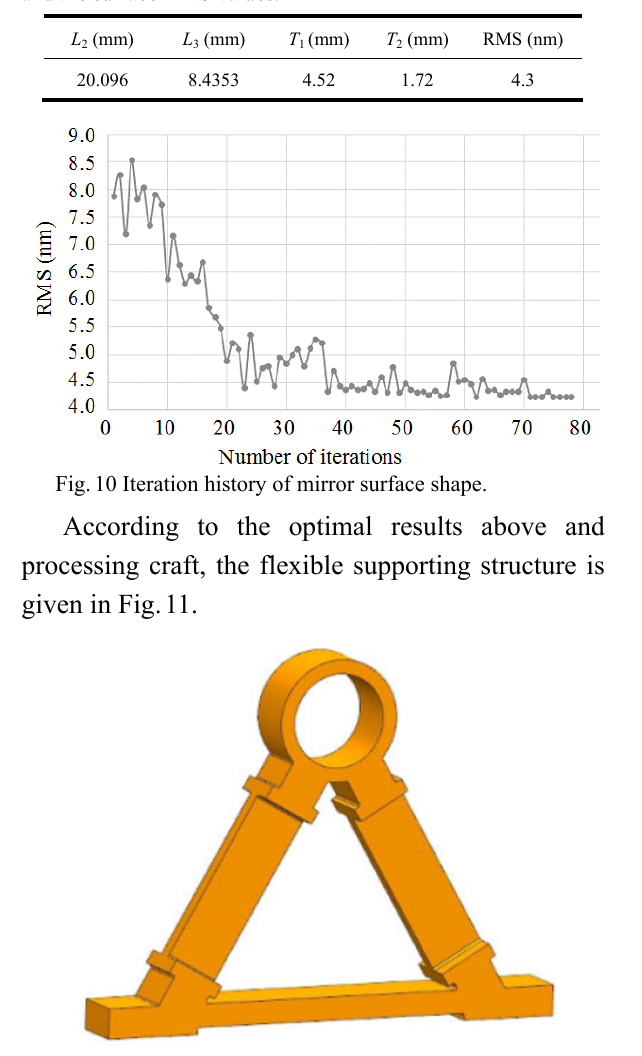
Fig. 11 Optimized structure of the bipod support.